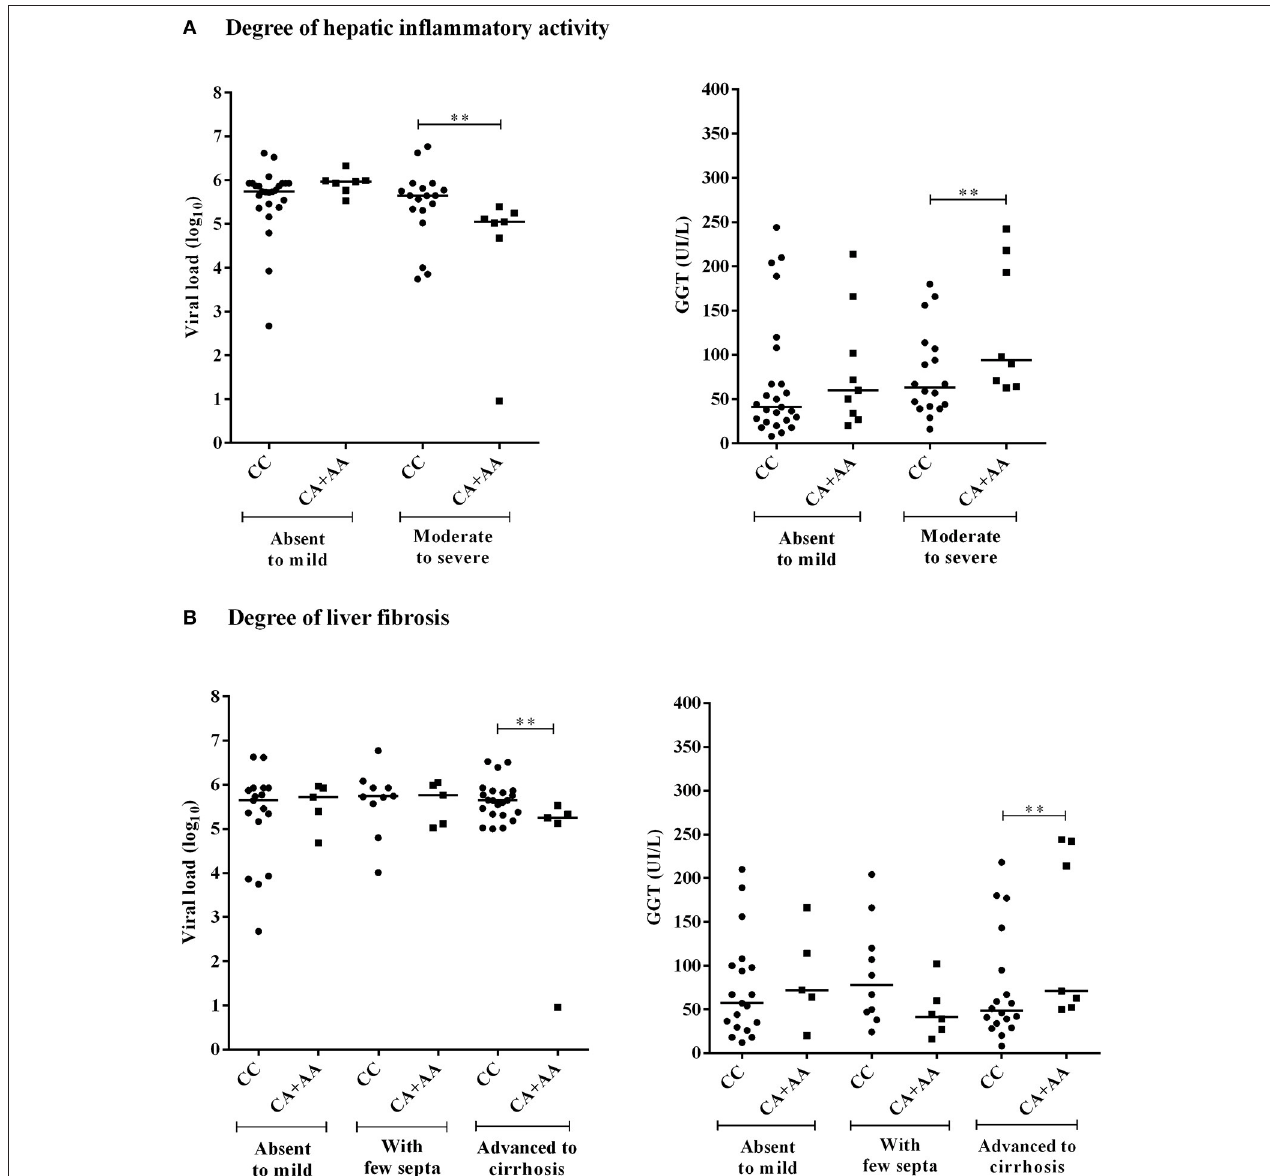
FIGURE 3 | Comparison of the plasma viral loads (log 10 ) and GGT levels among CHC patients with − 3279C > A polymorphism genotypes according to the degree of inflammatory activity (A) and liver fibrosis (B) . Significant changes in markers were observed at the more severe histopathological stages